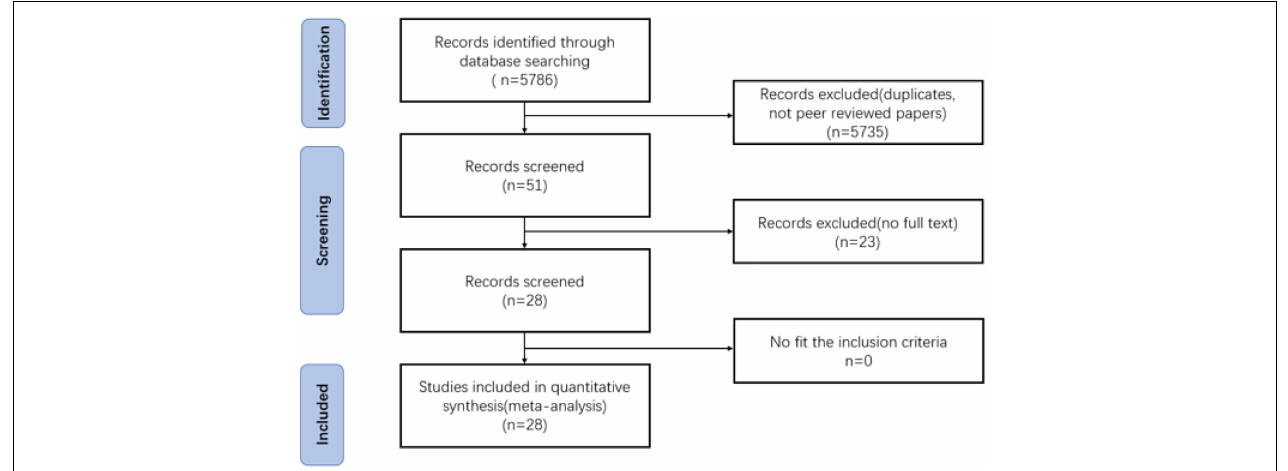
FIGURE 1 | PRISMA